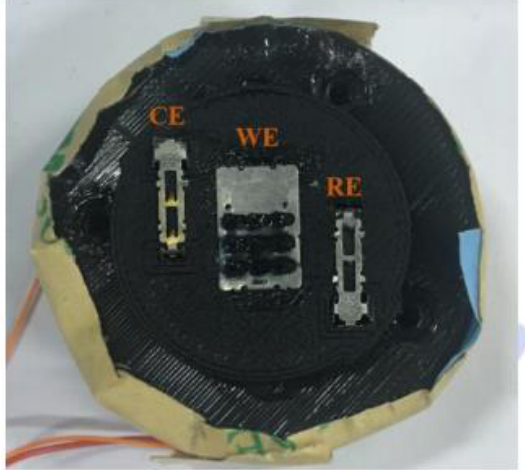
Figure 8. Three electrodes of the microneedle array, including working electrode (WE), counter electrode (CE), and separate reference electrode (RE). The WE is a 3 × 3 metal microneedle array, and the CE and RE are 2 × 1 metal microneedle arrays.